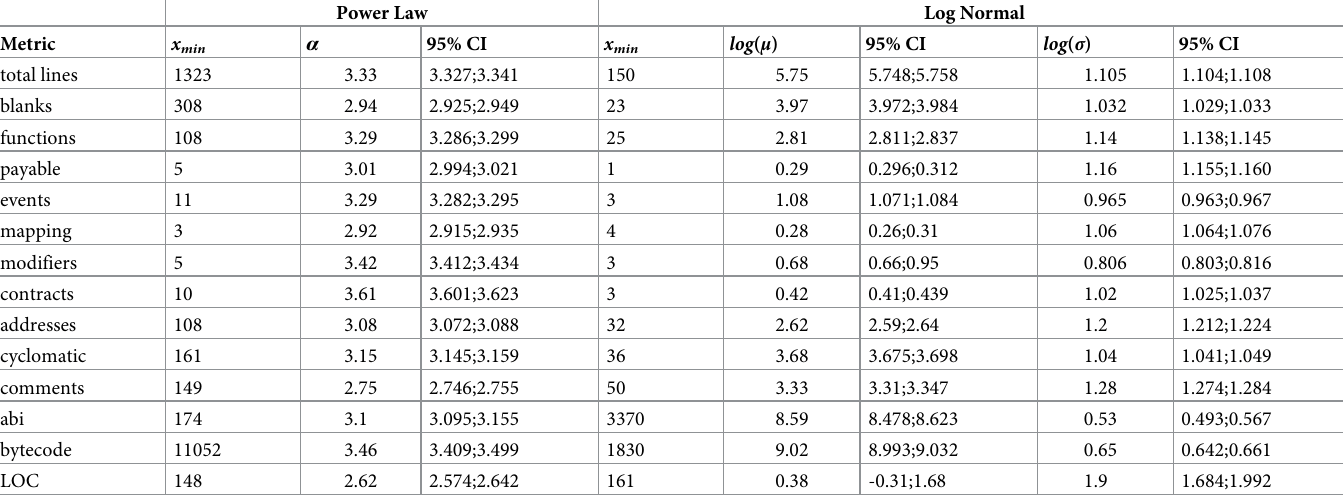
Table 3. Fitting parameters for the power law and log-normal distributions. The x min and α estimated parameters are reported for the Power Law. For the Log-Normal the x min , log ( μ ) and log ( σ ) estimated parameters are